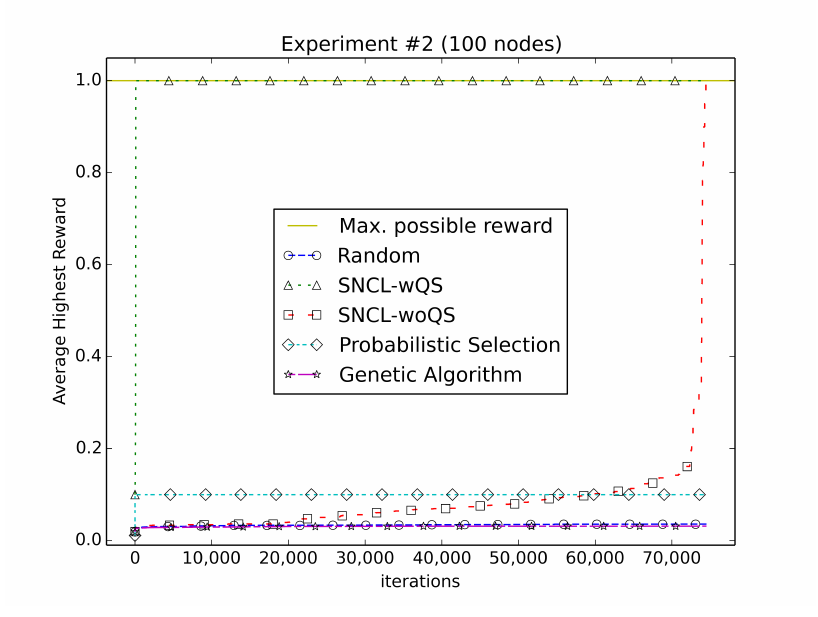
Figure 4. Using reward Equation (2).